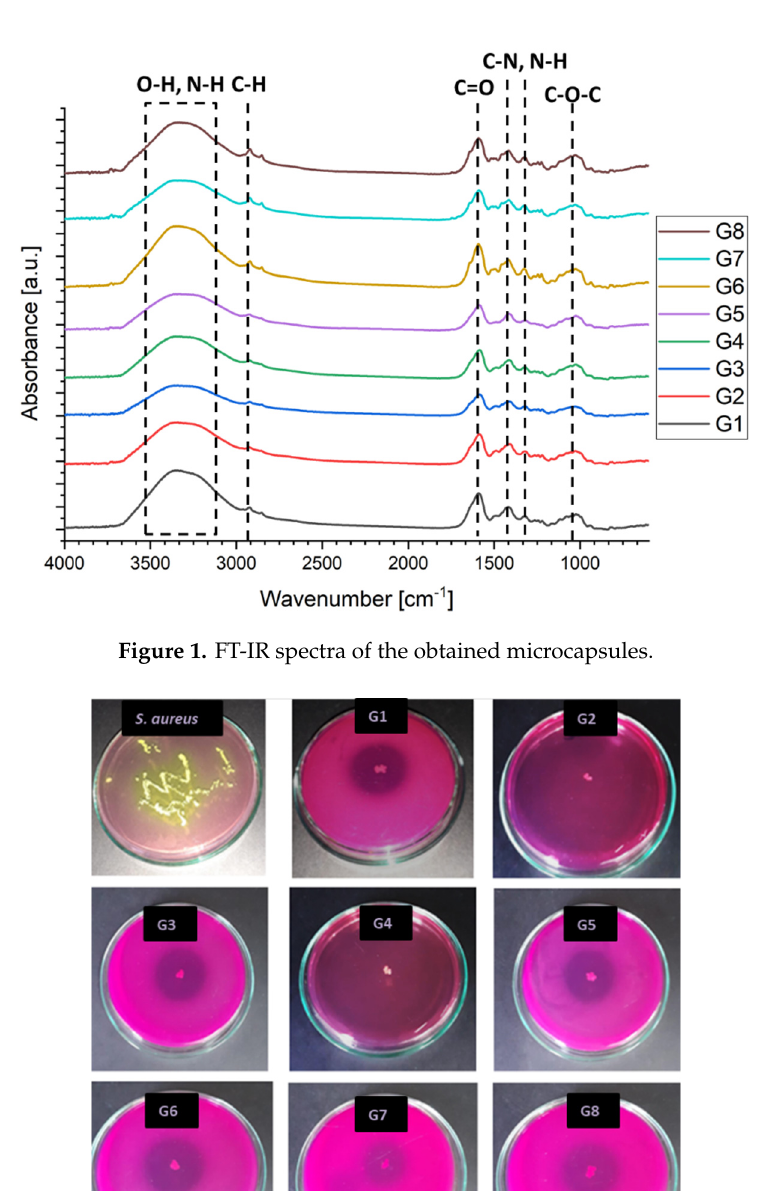
Figure 1. FT-IR spectra of the obtained microcapsules.